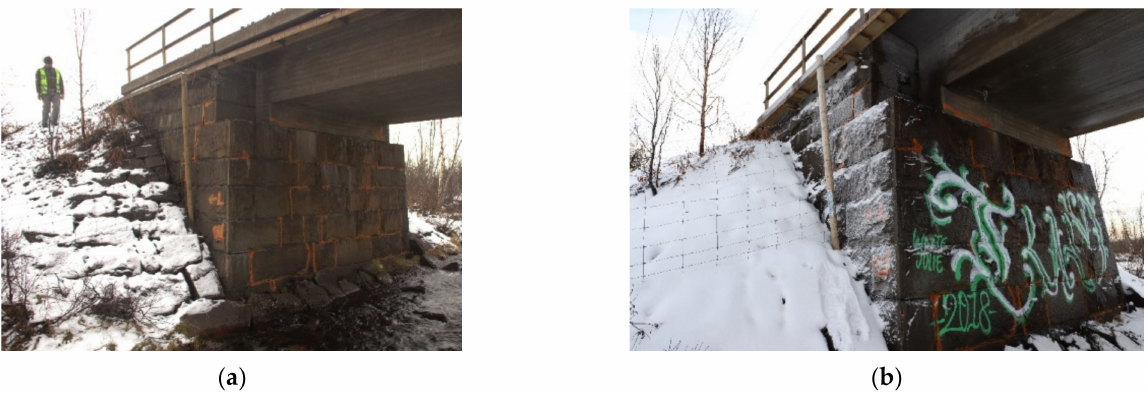
Figure 2. The same part of the Pahtajokk Bridge ( a ) first scan, ( b ) second scan. One year between